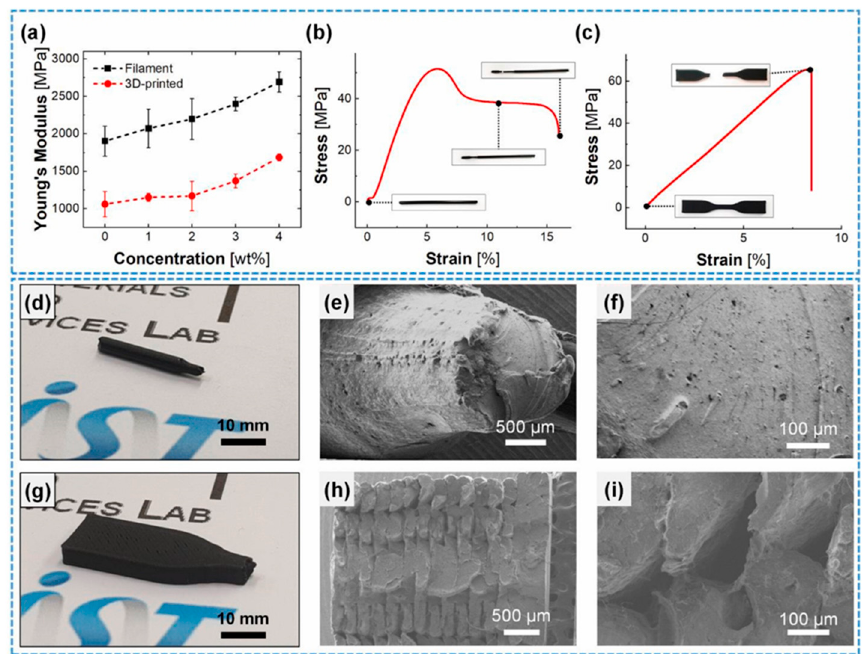
Figure 9. ( a ) Young’s modulus with various concentrations of MWCNT fillers. Stress-strain curve of 3 wt% ( b ) filament, ( c ) 3D printed specimen. Optical and SEM images of the fracture surface